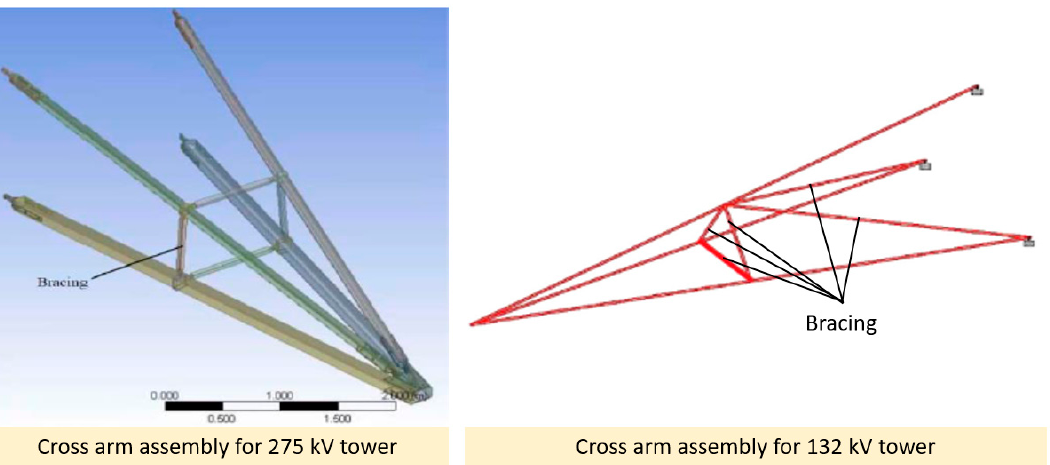
Figure 17. Design improvements of pGFRP composite cross arms in 132 and 275 kV transmission towers by the inclusion of a bracing system [29,140]. Reproduced with copyright permission from Creative Commons Attribution License 3.0.